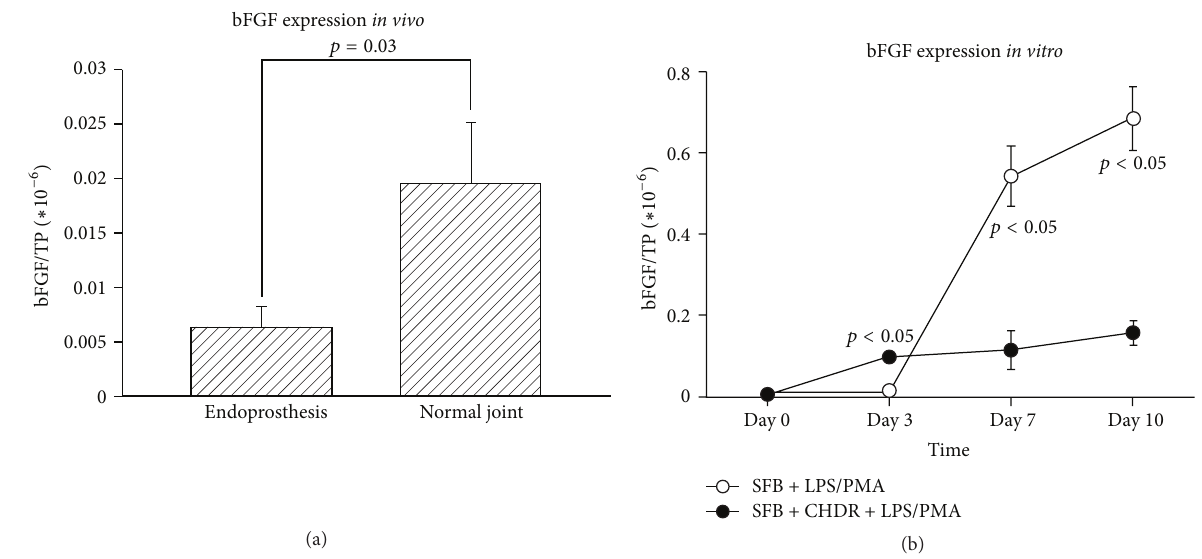
Figure 3: (a) shows that synovial bFGF levels were diminished in patients with an endoprosthetic implant (no cartilage) compared to those with normal joints (with cartilage). This difference reached statistical significance. (b) demonstrates the in vitro model’s corresponding data; here, time-dependent regulation patterns revealed increasing bFGF concentrations in all groups over time. bFGF levels were higher in the group with CHDR on day 3, but lower on days 7 and